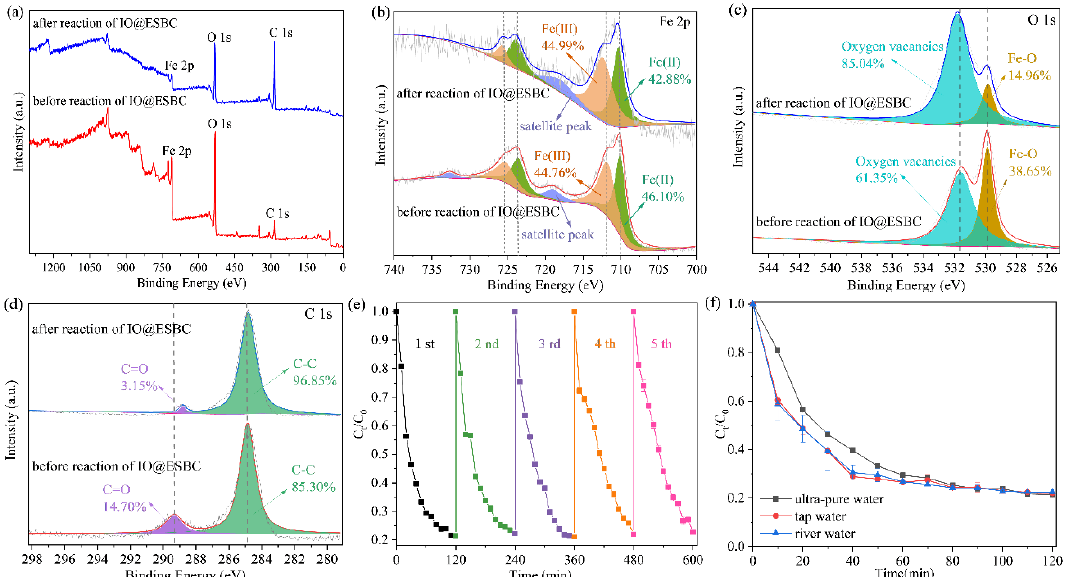
Figure 7. ( a ) XPS analysis of survey of IO@ESBC before and after reaction; ( b ) Fe 2p; ( c ) O 1s; ( d ) C 1s; ( e ) Recyclability of IO@ESBC; ( f ) Effect of different water quality in IO@ESBC/PS/TCH system. Experimental conditions: PS concentration of 10 mM, TCH dosage of 50 mg/L, IO@ESBC dosage of 1.25 g/L, and initial